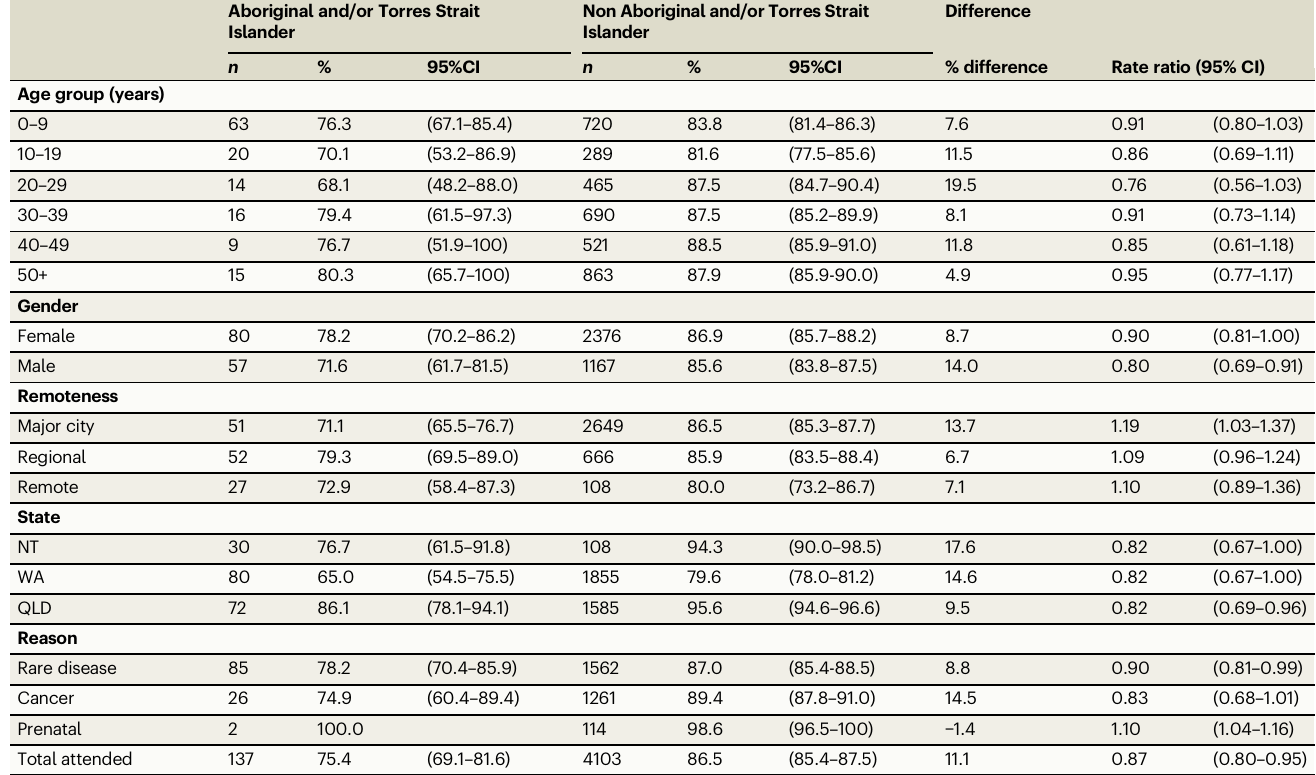
Table 4 | Disparity in annual attendance for Aboriginal and/or Torres Strait Islander people (univariate analysis) Aboriginal and/or Torres Strait Non Aboriginaland/orTorresStrait Islander